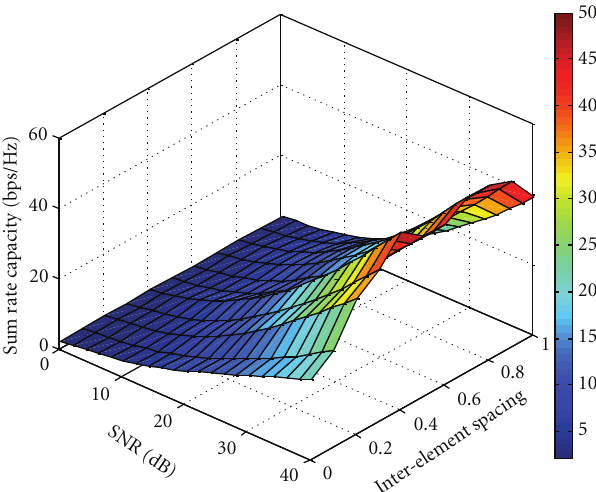
Figure 5: Surface of sum rate capacity with regard to interelement spacing at MSs and SNR for a 2 × (3 × 6) multiuser MIMO system without mutual coupling taken into account .